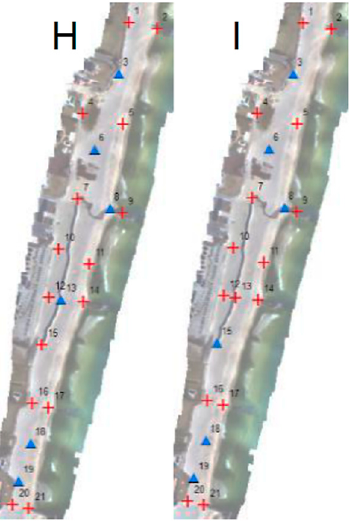
+ ) and check points ( (cid:78) )).